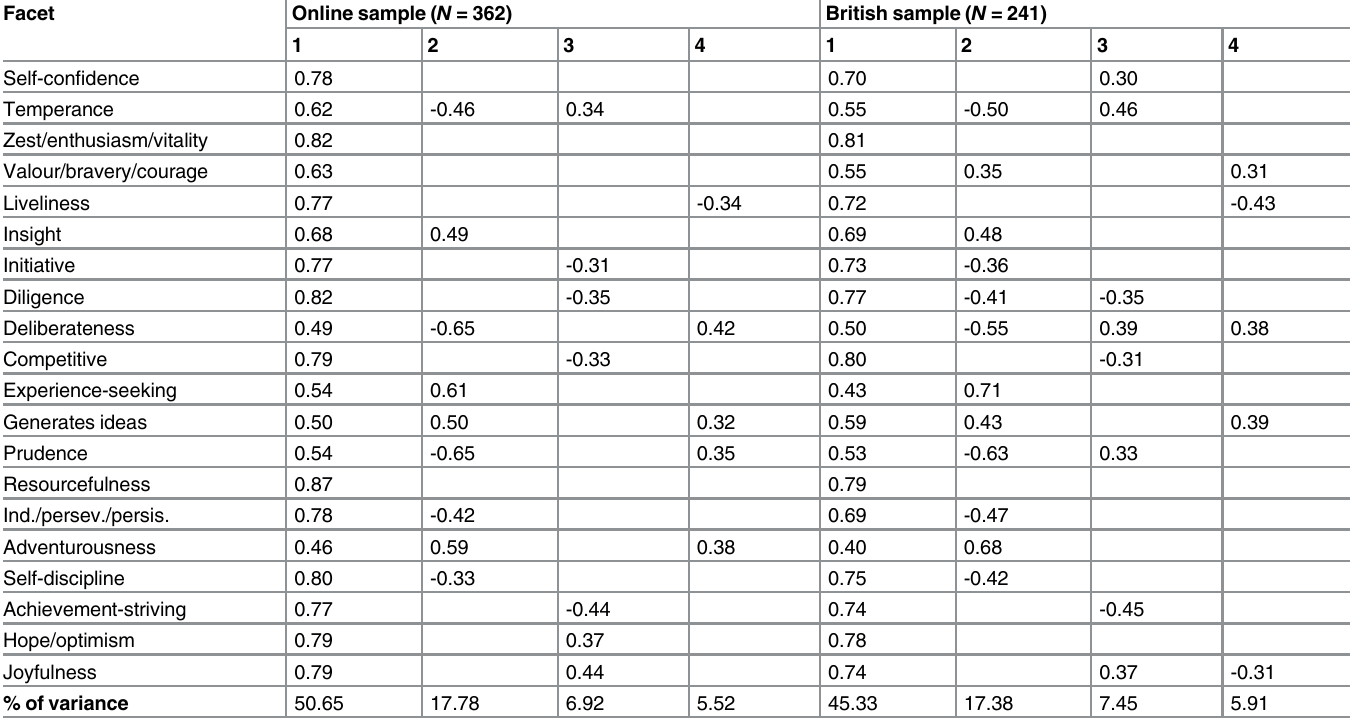
Table 2. Principal Component Loadings of IPIP Facet Scales in the Online and British Samples.